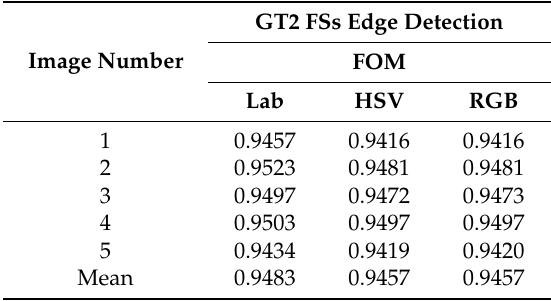
Table 5. GT2 FSs edge detection applied on Lab, HSV, and RGB color format